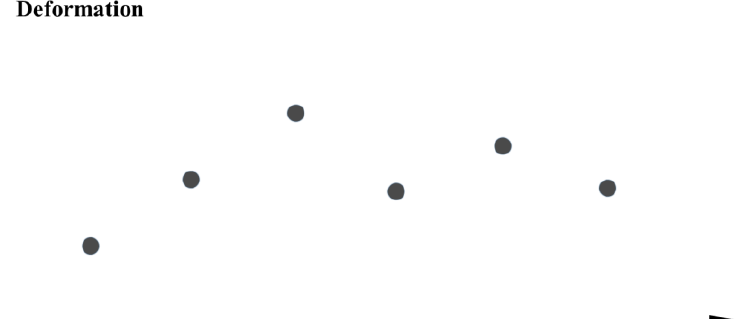
Figure 2. Cross-section data diagram.